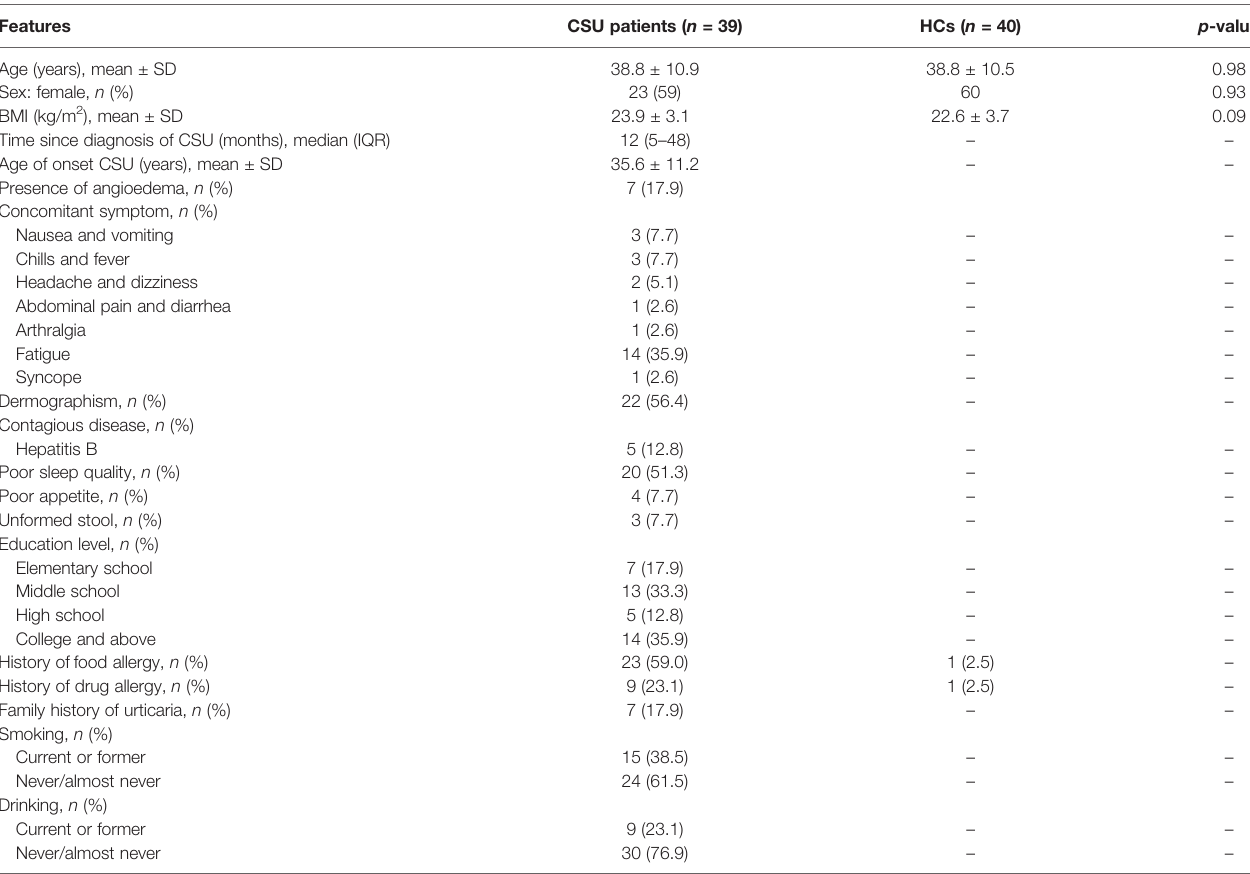
TABLE 1 | Demographic and clinical characteristics of